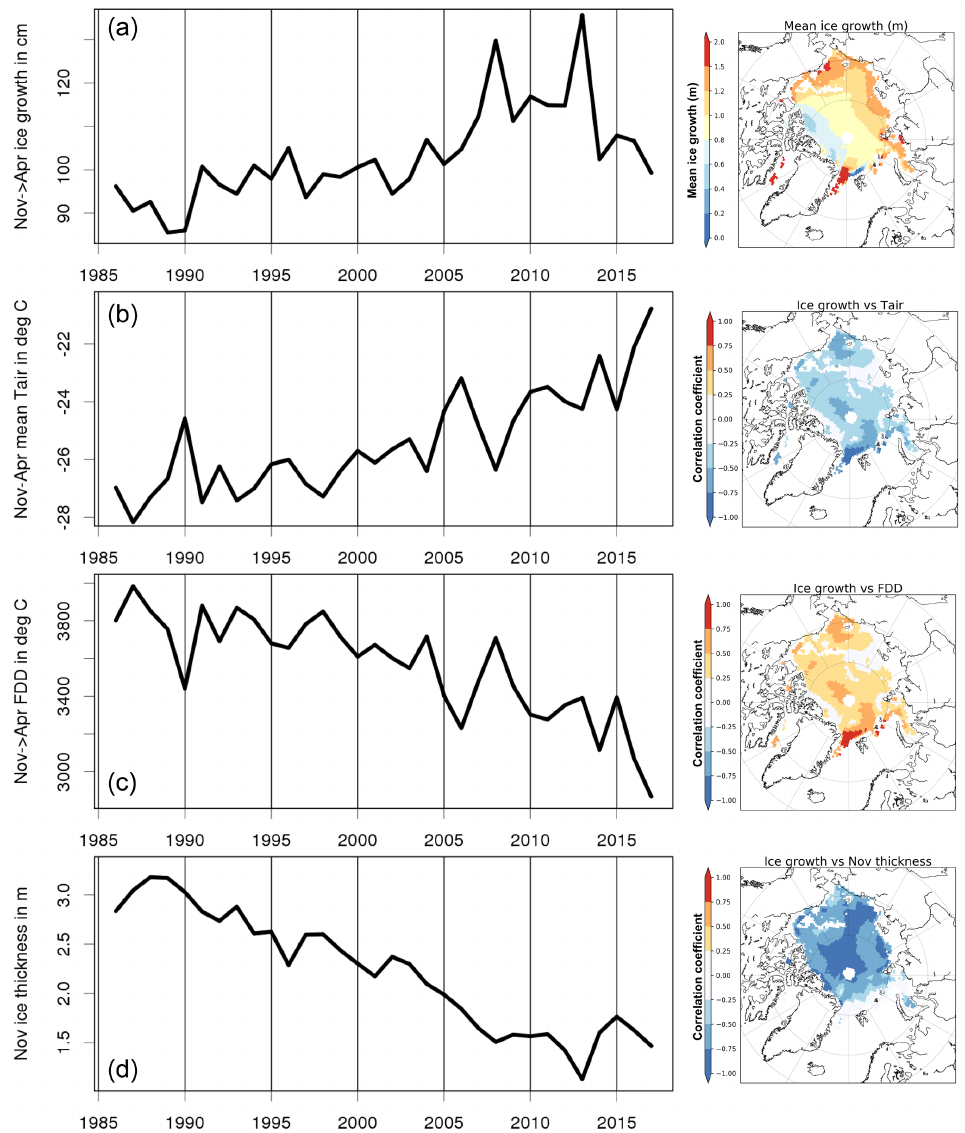
Figure 9. Time-series from 1985 to 2017 of mean winter ice growth (mid-November to mid-April) in the free CICE simulation (a) , mean 2m NCEP-2 air temperature (b) , cumulative freezing degree days (FDDs) (c) and November ice thickness (d) . All time-series results are averaged over the areas shown in Fig. 1c. Corresponding images to the left of each time-series plots show the following: mean ice growth from November to April as averaged from 1985/1986 to 2016/2017; correlation coefficient between ice growth and 2m NCEP-2 air tem- perature; correlation coefficient between ice growth and FDDs; and correlation coefficient between ice growth and November ice thickness, respectively. All correlation values are given for linear regression of de-trended time